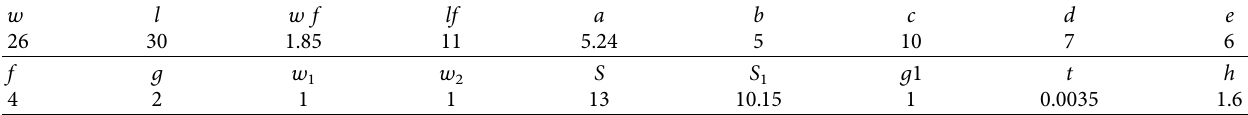
Table 1: Parameter values of the proposed low-SAR penta-band microstrip patch antenna (values are in mm). w